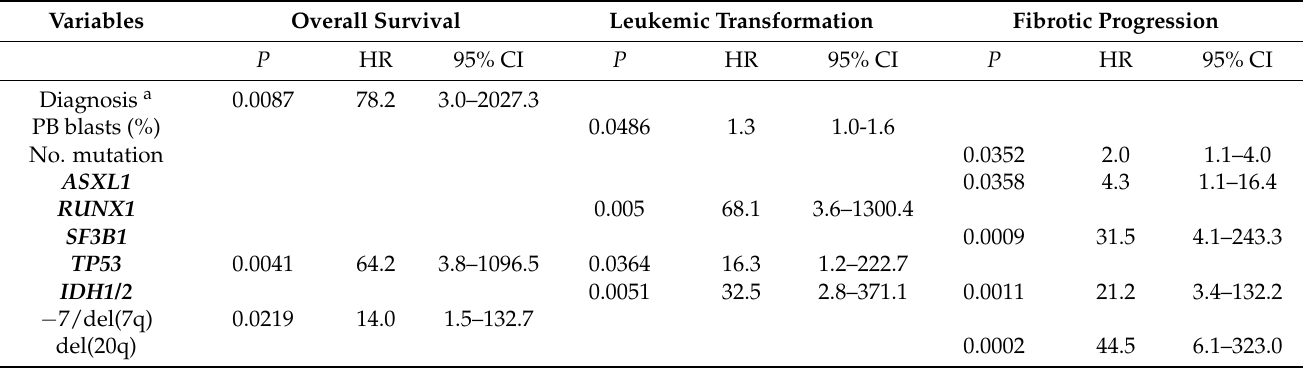
Figure 2. ( A ) Overall survival curves of the patients according to disease category. ( B ) Hazard ratios of significant factors for overall survival and ( C ) leukemic transformation in PV, ET, PMF and ( D ) fibrosis progression in PV and ET patients. PV: Polycythemia vera, ET: essential thrombocythemia, PMF: primary myelofibrosis, MPN: myeloproliferative neoplasm, No: number and abn: abnormal. Table 3. Multivariate analysis of clinical and genetic factors for overall survival, leukemic transformation and fibrosis